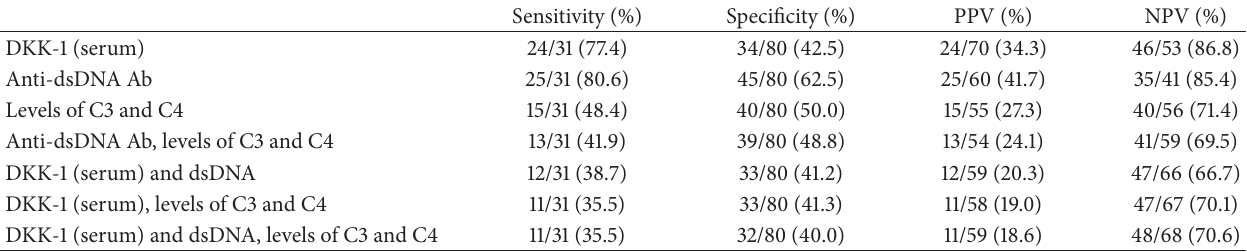
Table 4: Significant difference in levels of serum DKK-1 and anti-dsDNA antibodies, C3, and C4 in patients with LN-SLE compared to non-LN-SLE